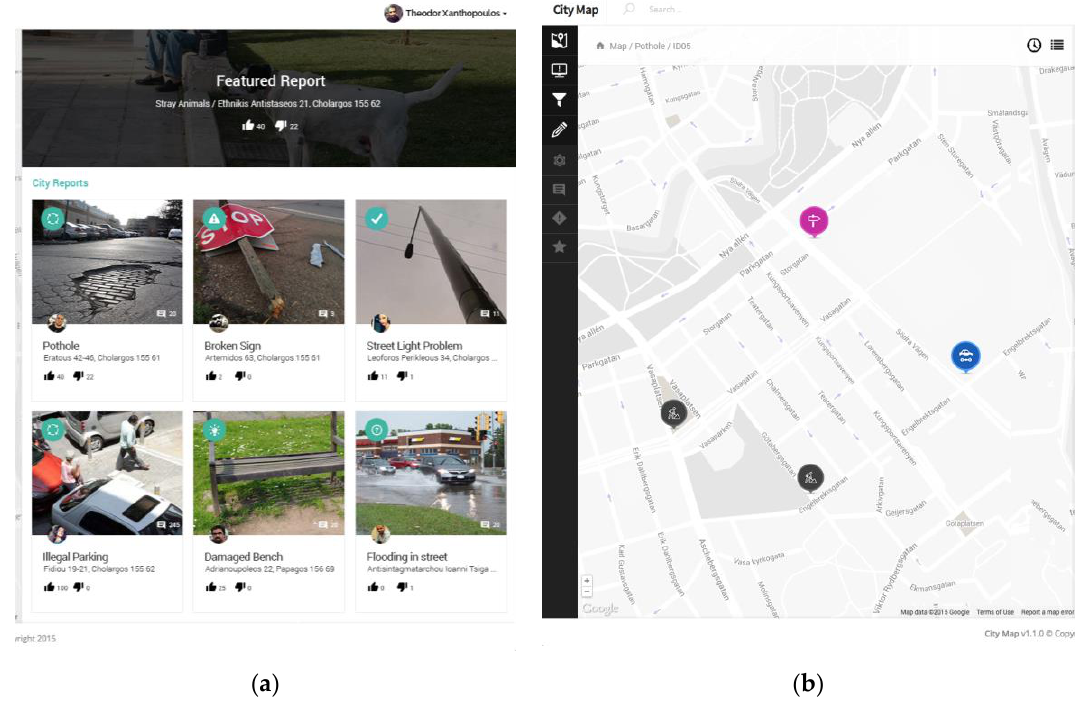
Figure 3. Web application: ( a ) left is observed the municipality map with road addresses; ( b ) right are observed the emerged problems that should be fixed by the system.